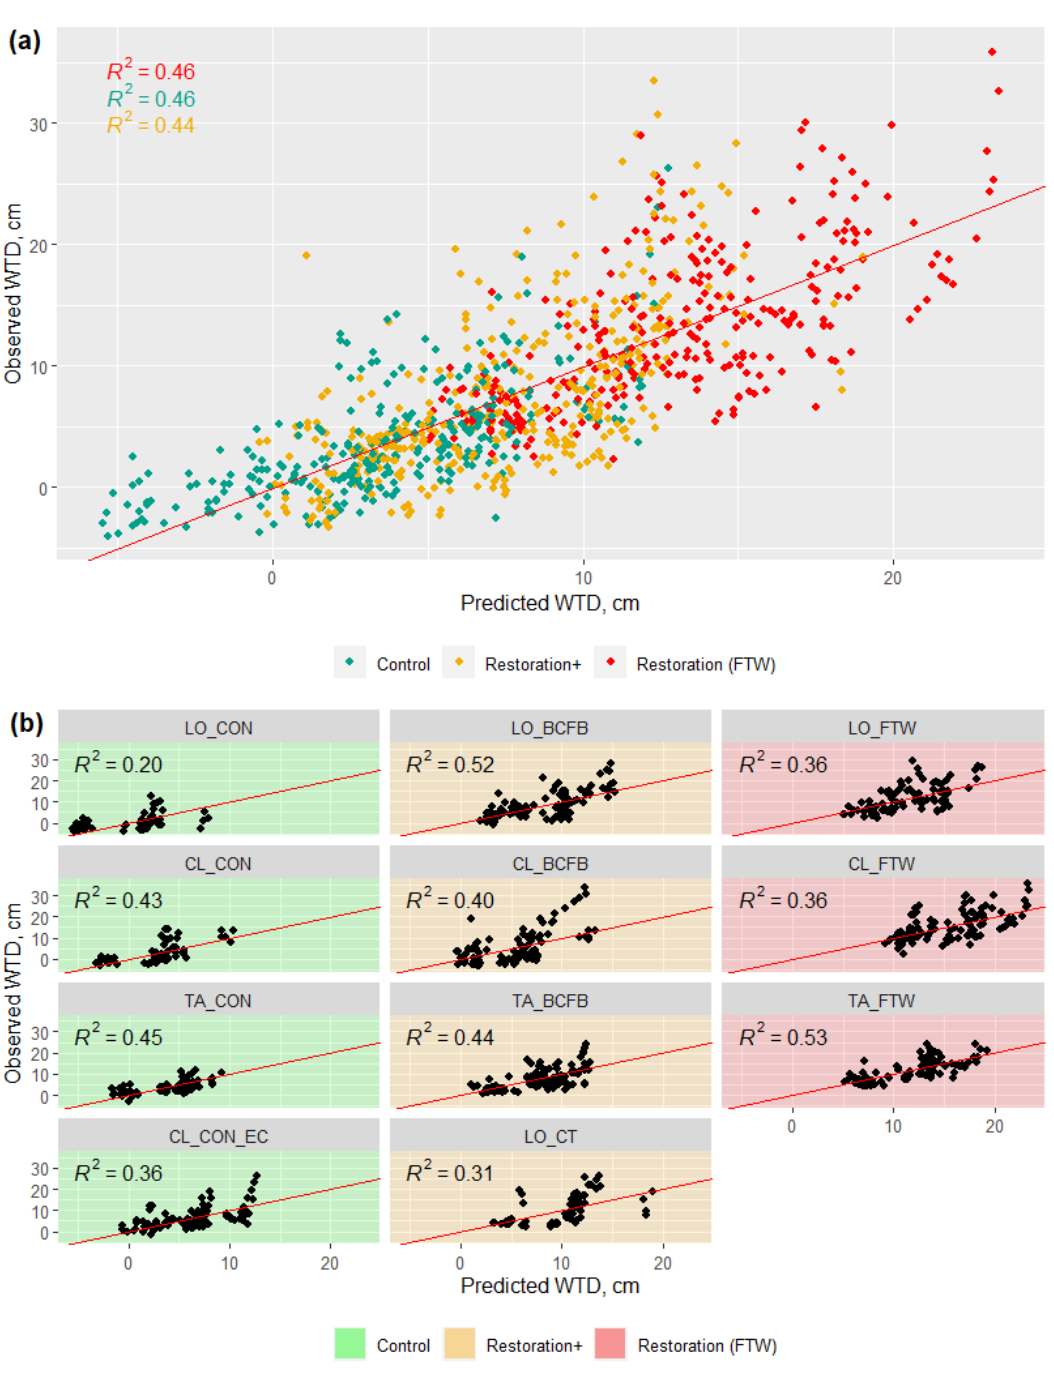
Figure 7. MLR model output for Forsinard Flows sites (predicted vs. observed WTD) for ( a ) all data points; ( b ) splitting data into the individual sites. The red line represents a perfect agreement between the prediction and the field measurement.